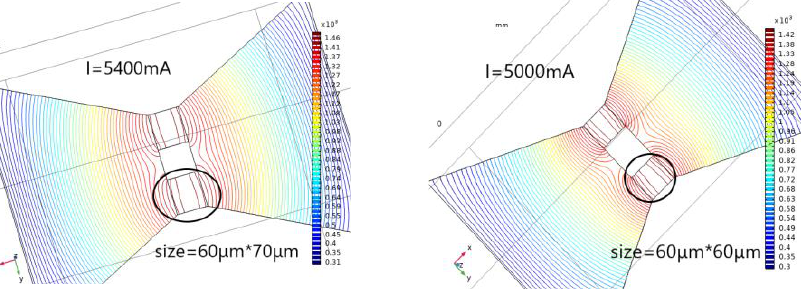
Figure 8. Multi-physical field simulation results of solid-state ON–OFF switch diversion layer in double bridge area.